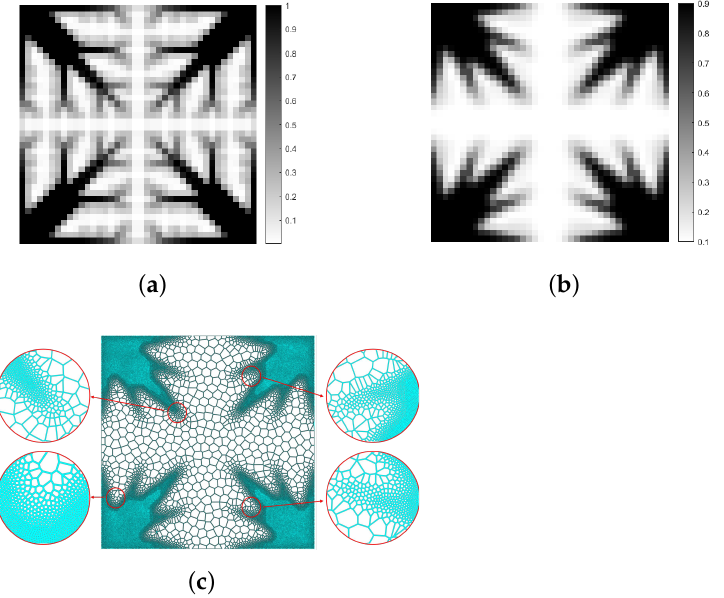
Figure 10. Results of uniform distributed heating (II): ( a ) the relative density distribution obtained by the SIMP method; ( b ) the relative density distribution obtained by the proposed multiscale method; ( c ) the reconstructed